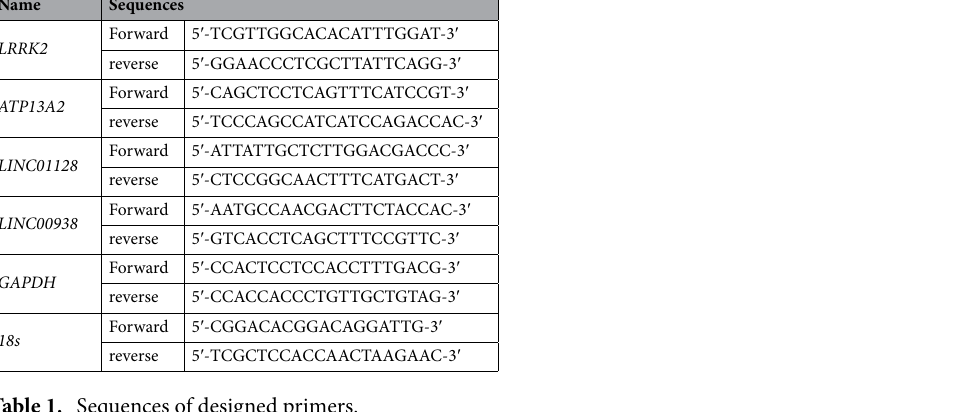
Table 1. Sequences of designed